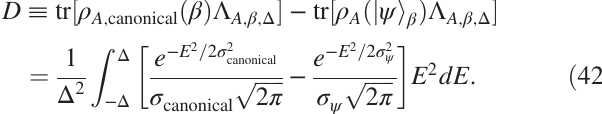
FIG. 11. Top panel: Subsystem energy variance with respect to subsystem size L for both the canonical ensemble (blue circular A markers) and a single eigenstate j ψ i β (red diamond markers), at L ¼ 18 and β ¼ 0 . 3 . The inset shows the ratio between the energy variances at each subsystem size, which is expected to fit 1 − L =L in the thermodynamic limit [Eq. (8)]. Bottom panel: A P L A ≡ The variance of an operator J ð h ð i Þ x σ x þ h ð i Þ z σ z Þ þ A i i i ¼ 1 P L A − 1 σ z J ð i Þ z σ z , which includes the same terms as H but A i i þ 1 i ¼ 1 does not relate to energy conservation, is plotted for comparison. Here, the quantities h ð i Þ x , h ð i Þ z , and J ð i Þ z are each taken from the uniform distribution ½ − 1 ; 1 (cid:2)